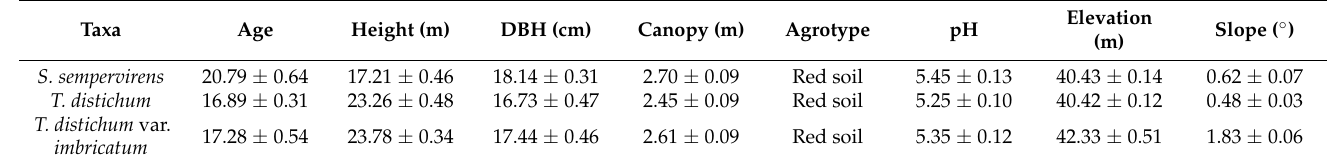
Table 1. Habitat and structural or densitometric characteristics of the target Cupressaceae